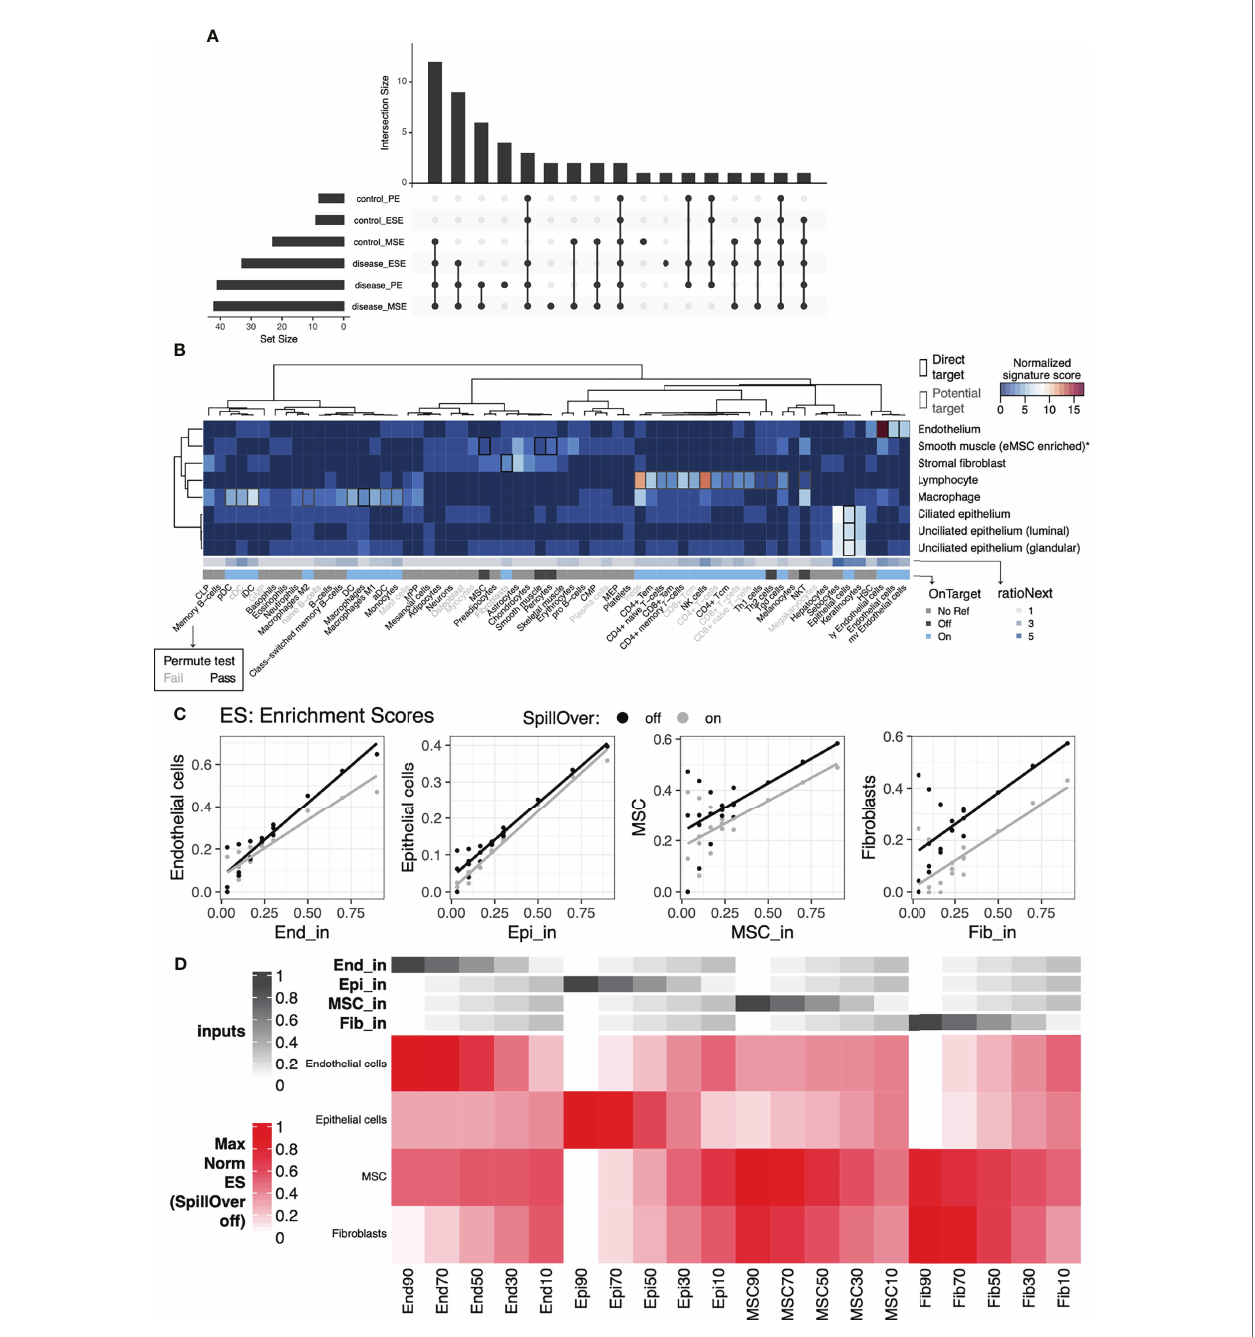
FIGURE 2 | Cell-type speci fi c signature validation for endometrial tissue. Evaluation of xCell ’ s 64-cell-type signature compendium and endometrial cell types identi fi ed via scRNAseq and arti fi cial mixtures analysis from sorted cell types. (A) Upset plot showing patterns of conditions in which cell-type signature scores were signi fi cantly higher than permuted null distributions (top), as well as the sizes of each individual set (left). (B) Sensitivity (normalized signature score), speci fi city (RatioNext), and relationship (onTarget) between xCell ’ s 64 signatures with endometrial cell types identi fi ed at the single cell level. Shown in the heatmap are signature scores evaluated as percentage of genes in a given xCell signature that were differentially expressed between cells in an endometrial cell type compared to the remaining cells. Scores were normalized by row mediums. (C) Scatter plots of xCell enrichment scores (y-axis) versus input percentage (x-axis), for each input cell type, with least-squares regression line overlaid, for arti fi cial mixtures with (gray) and without (black) the SpillOver step. (D) Heatmap of relative, normalized to the max across all mixes, enrichment scores with annotations at the top indicating the input percentage of each cell type. End, endothelial cells; Epi, epithelial cells; MSC, mesenchymal stem cells; Fib,